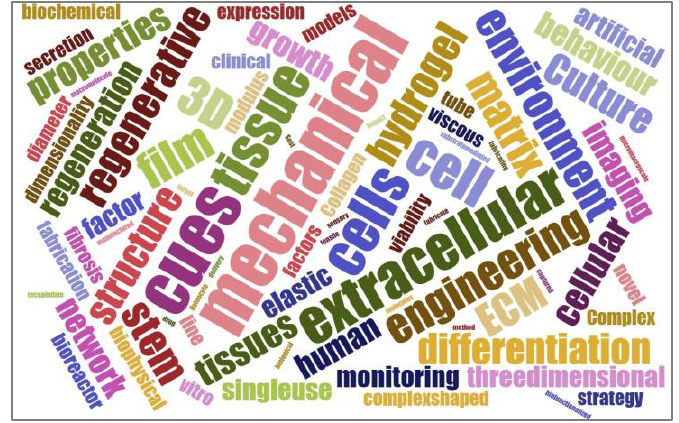
Figure 1. Word cloud reflecting the contents of this Special Issue.